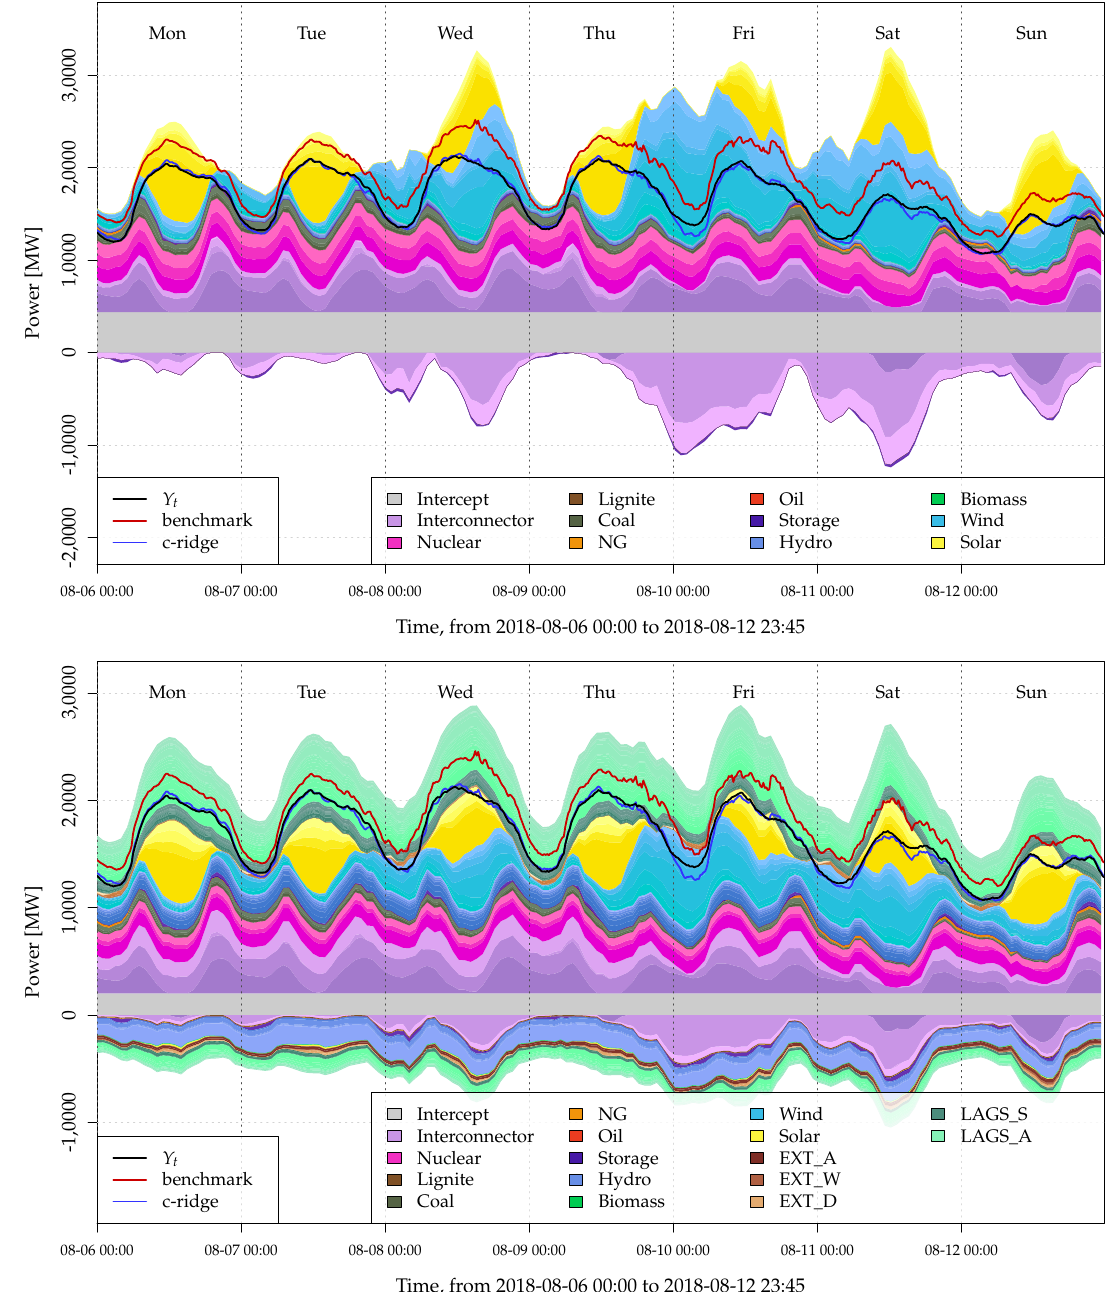
Figure 7. Time series plot of the actual load Y t (black), with the fitted model of the benchmark model (red) and the c-ridge ∗ approach (blue) on 6–12 August 2018. Additionally, the estimated impact of the single components (cid:98) β i X i , t for the c-ridge ∗ model (bottom) and benchmark model (top) classified by type with different colors is